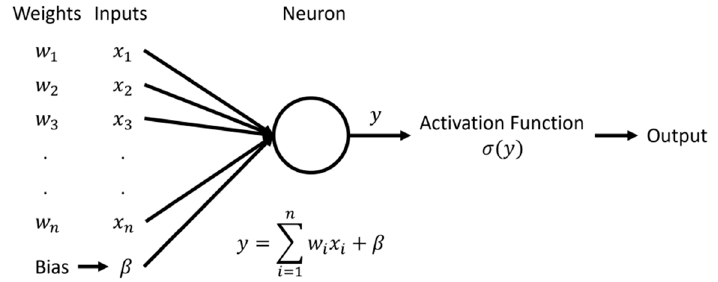
Figure 10. Illustration of an individual neuron.